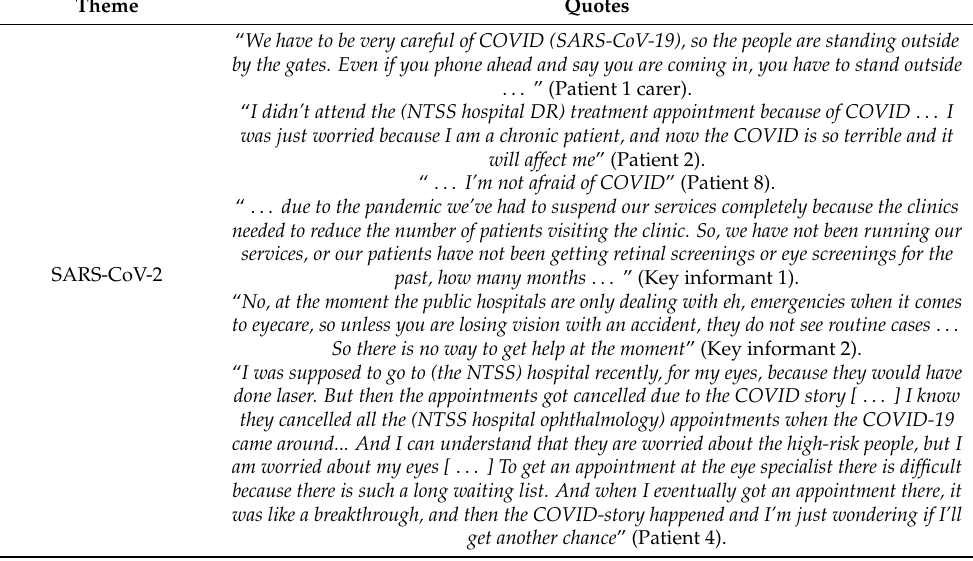
Table 6. SARS-CoV-2-related